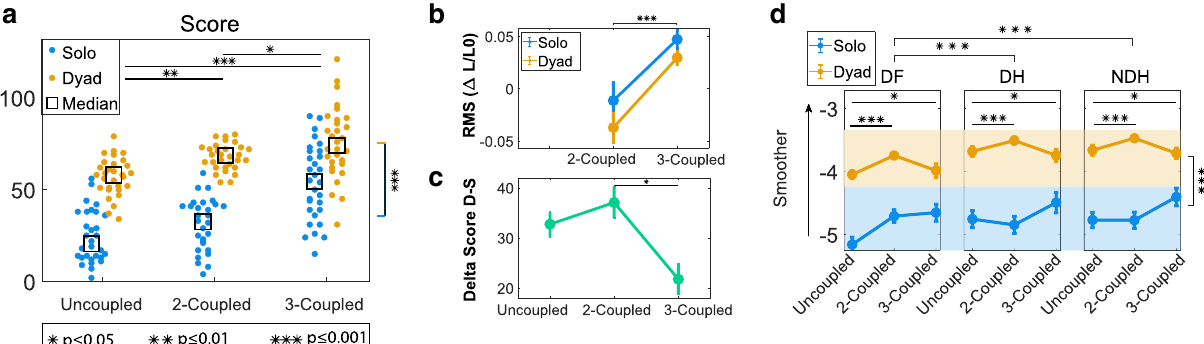
Figure 3. Performance: ( a ) Score for Uncoupled, 2-Coupled and 3-Coupled task. Each dot represents the value of the last trial. Blue dots correspond to solo sessions; orange dots correspond to paired sessions; squares represent median values. ( b ) Spring length variations ( � L / L 0 ) in 2-Coupled and 3-Coupled tasks. ( c ) Delta score between Dyad and Solo. ( d ) Limb’s Smoothness (spectral arc length) for Uncoupled, 2-Coupled and 3-Coupled task (DF: Dominant Foot, DH: Dominant Hand and NDH: Non-Domimant Hand). Each dot represents the average value of the last trial, while bars represent the standard error. The ‘*’ symbol is used to mark the statistically significant results, with * for p (cid:31) 0.05 , ** for p (cid:31) 0.01 and *** for p (cid:31) 0.001 . All reported p -values correspond to a significance level of